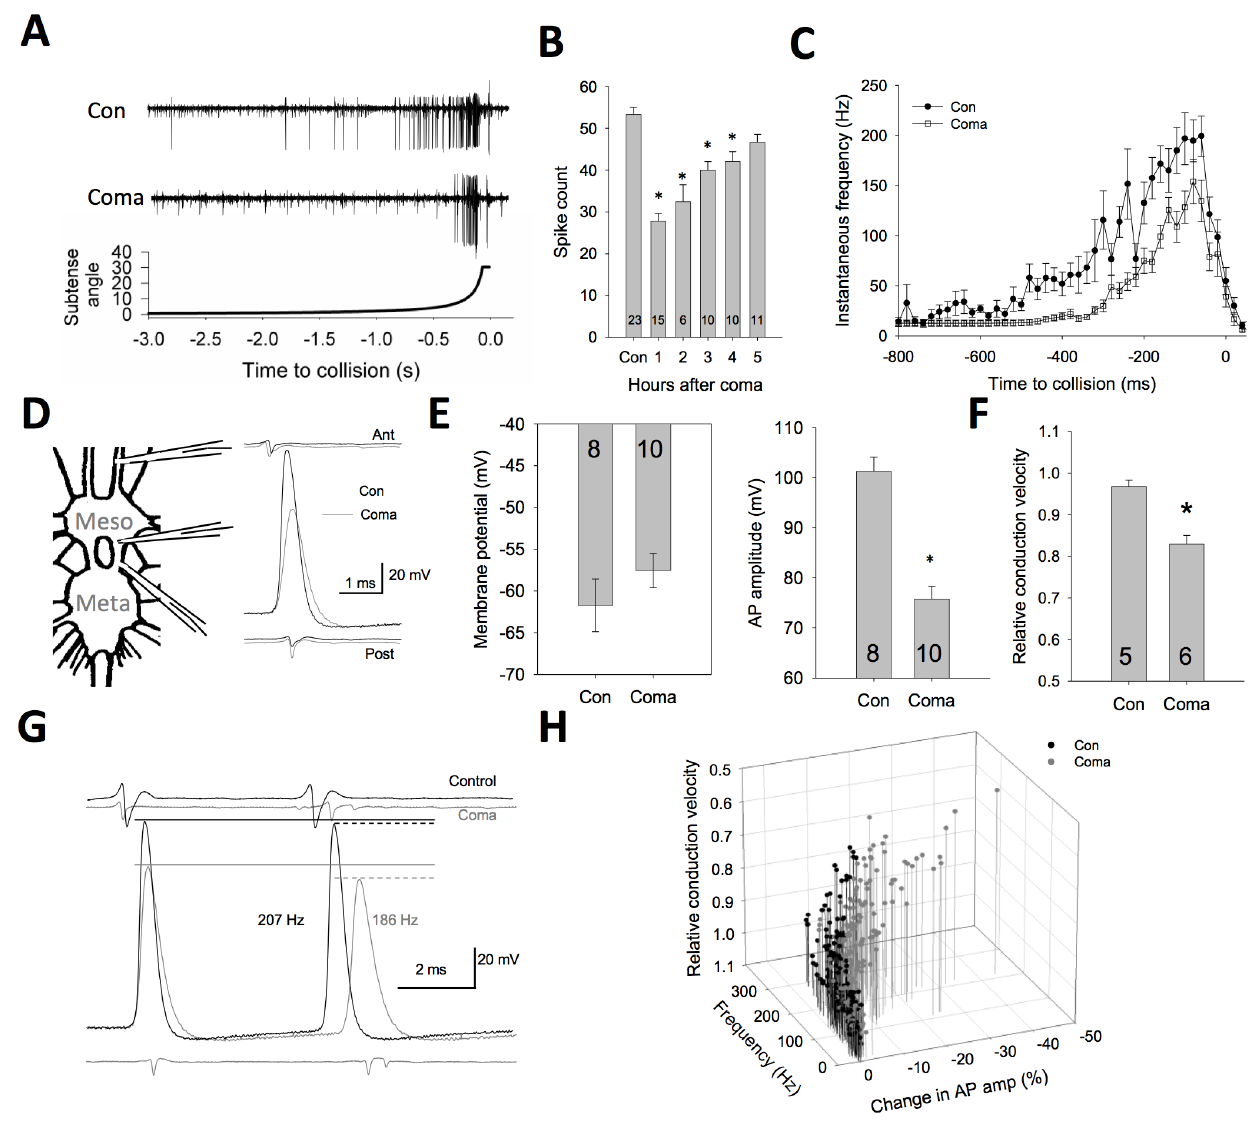
Figure 2. Performance is temporarily reduced after anoxic coma induced by water immersion. ( A ). Raw traces of DCMD activity in response to a looming target stimulus (bottom panel) demonstrate a delay of the response relative to target collision as well as a loss of overall spike activity. ( B ). The reduction in mean spike count is most prominent at 1 hour of recovery, and gradually returns to control levels over a period of 5 hours. ( C ). Peristimulus time histogram of grouped data showing instantaneous frequencies of action potentials during target approach with coma recovered animals having a delayed latency and lower peak activity compared to control animals. ( D ). Illustration of recording arrangement with two extracellular electrodes (ant, anterior; post, posterior) across the mesothoracic ganglion and an intracelullar electrode immediately posterior to the ganglion. Traces are overlayed at the start of the intracellular AP rising phase. ( E ). An examination of AP properties of the DCMD axon recorded from this region compared between control and coma recovered animals reveal a mild resting membrane depolarization and a significant reduction in AP amplitude in coma-recovered animals. ( F ). Coma-recovered animals also show a decrease in the conduction velocity between the extracellular electrodes. ( G ). Frequency-dependent AP amplitude attenuation between events with similar instantaneous frequency from control and coma- recovered animals. APs from coma recovered animals both start with APs of lower amplitude and lose amplitude to a higher degree than controls. ( H ). Group scatter data of individual APs during a looming response plotted to show the relationship between AP instantaneous frequency, AP amplitude loss, and conduction velocity. Coma-recovered animals show a marked instability of both AP amplitude and conduction velocity with increasing instantaneous frequency. Asterisks denote statistical significance (P , 0.05). Number of animals per condition is noted within the bars, valued as mean 6 SE. the wingbeat frequency (Figure 3B). Coma animals had signifi- thorax on both the left and right sides into flight muscles (M97; cantly reduced responsiveness to the looming stimulus (t-test, P , [22]) and flew the animals on a fixed tether in a wind tunnel. Both 0.01; Figure 3C). Flight is known to affect the properties of the control and coma-recovered animals showed sustained flight, but looming circuit [27,28], making a direct comparison of the the flight durations in coma animals were significantly reduced (t- consequences of DCMD activity in the quiescent and flying animal test, P , 0.05; Figure 3A). A looming stimulus was displayed to the challenging. However, the results from the flight behaviour are flying animal and turning responses were identified by changes in